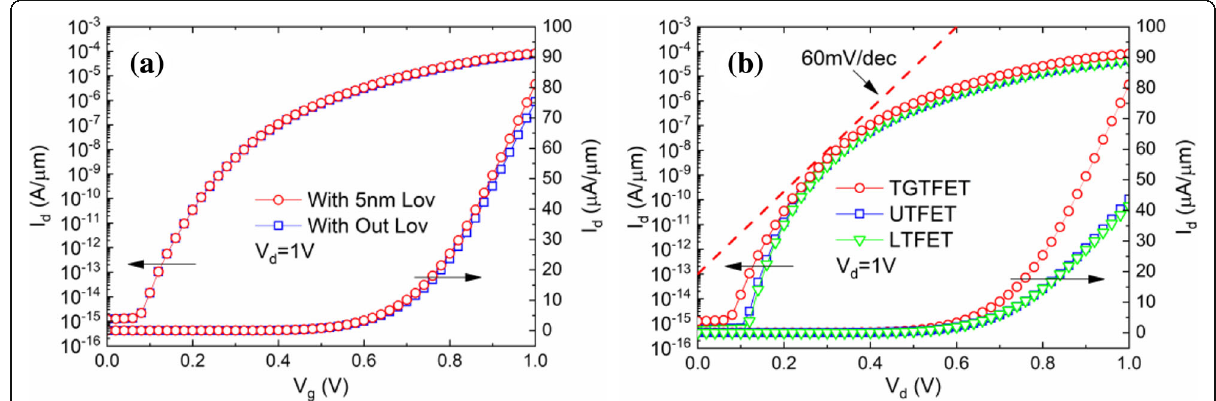
Fig. 3 Simulated a transfer characteristics of TGTFET with/without gate overlap and b transfer characteristics of TGTFET, UTFET, and